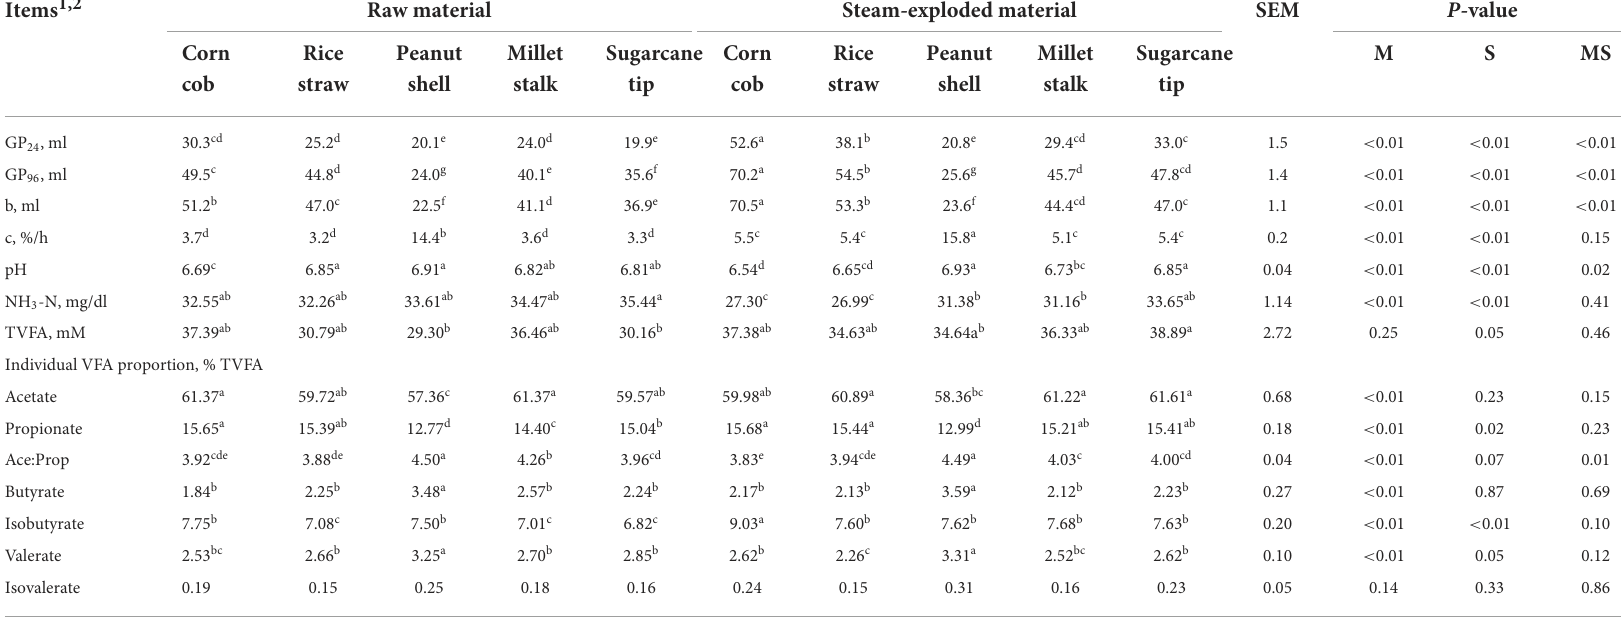
TABLE 3 In vitro rumen fermentation profile of feedstuff before and after steam explosion processing. Items